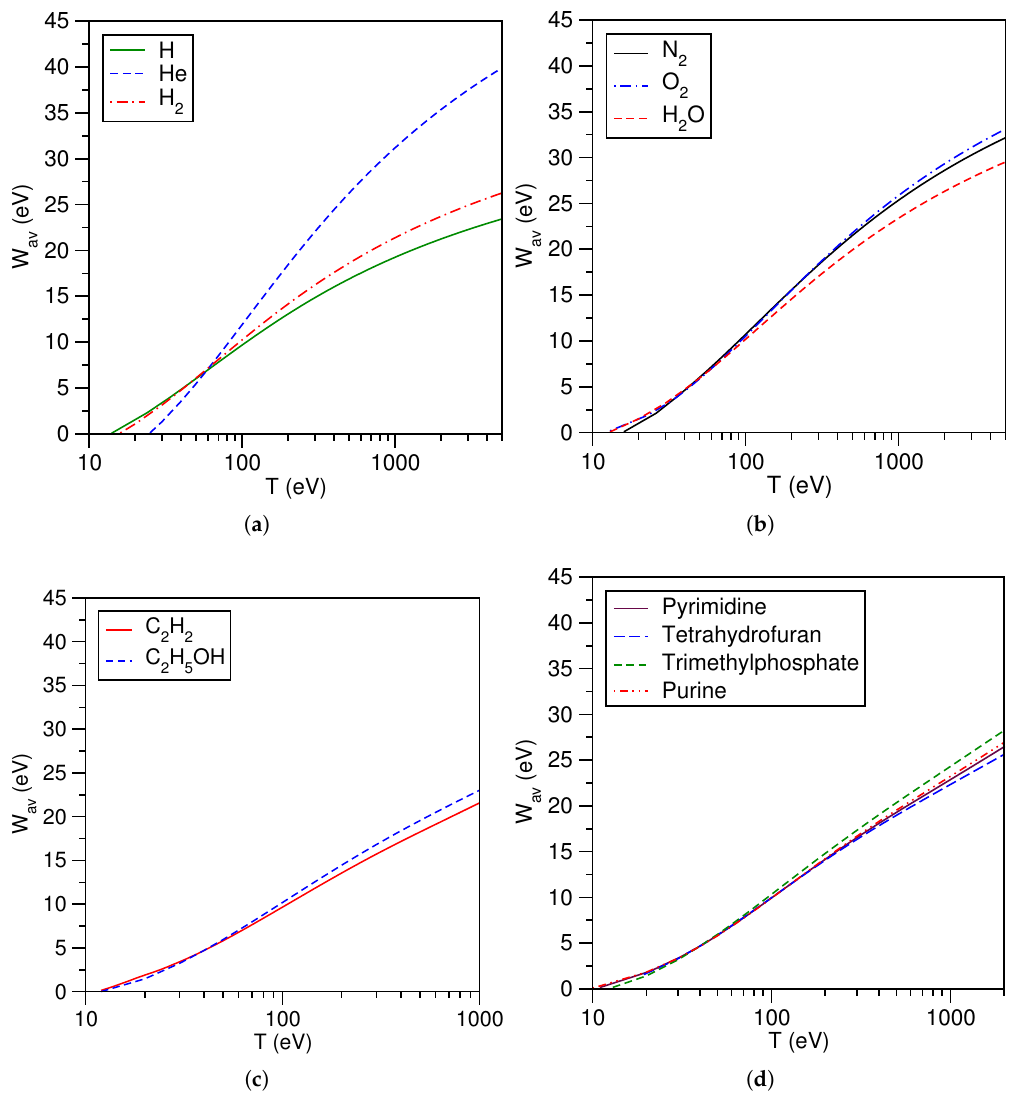
Figure 14. W av for ( a ) hydrogen atom, helium, and hydrogen molecule, ( b ) nitrogen molecule, oxygen molecule, and water molecule, ( c ) acetylene and ethanol, and ( d ) pyrimidine, tetrahydrofuran, trimethylphosphate, and